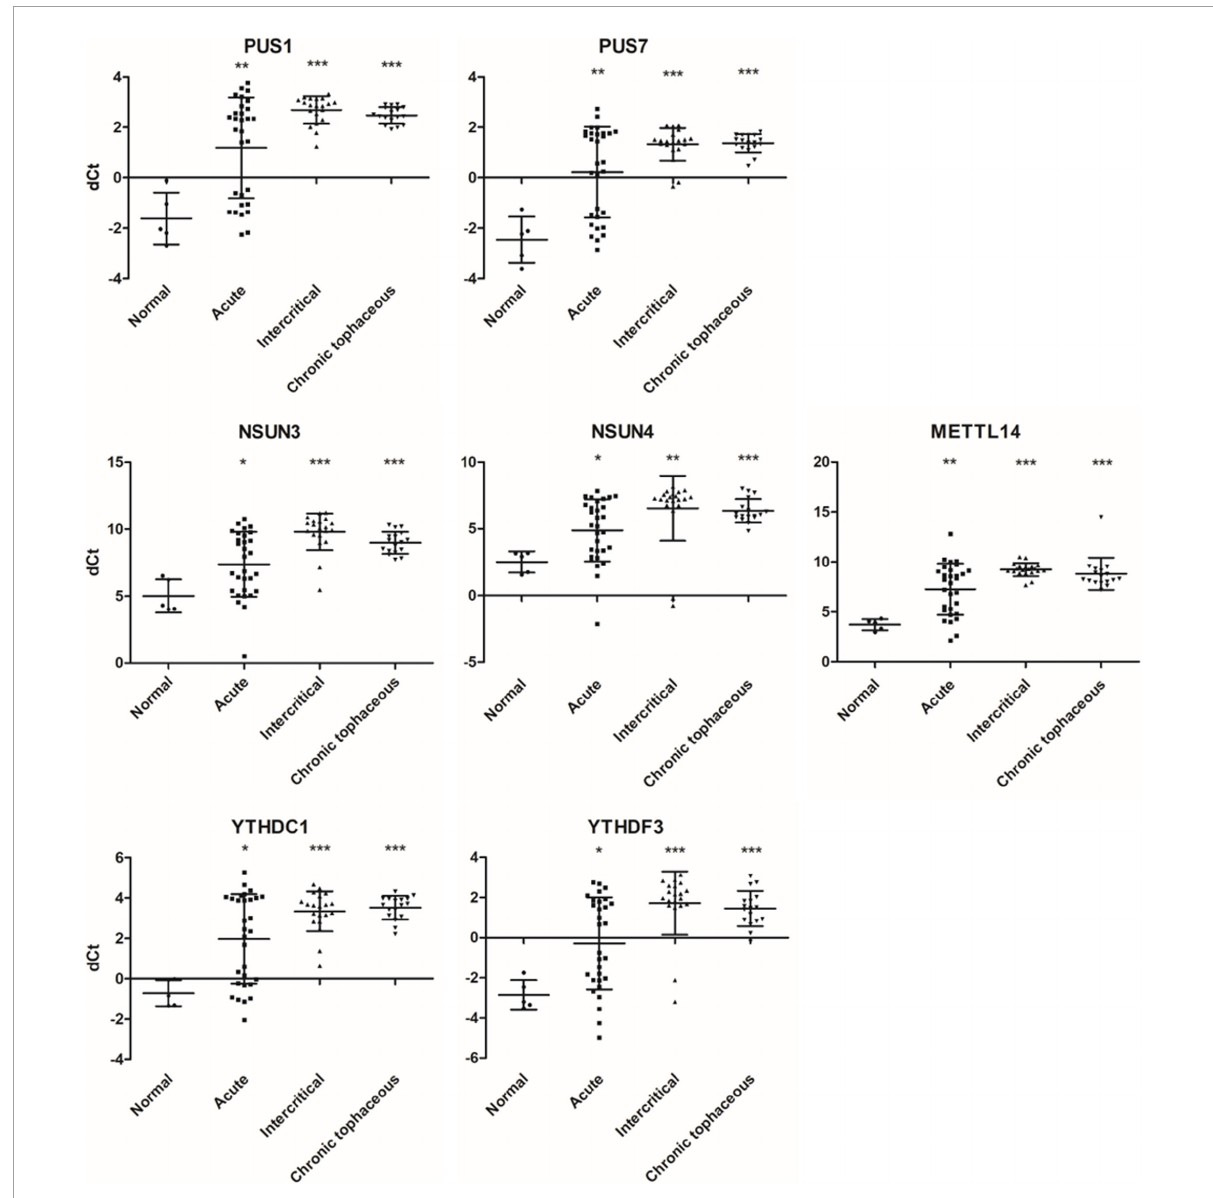
FIGURE9 RNA expressions of RNA modification enzymes were affected in patients with gout. The expressions of PUS1 , PUS7 , NSUN3 , NSUN4 , METTL14 , YTHDC1 , and YTHDF3 were detected through real-time PCR in 67 patients with gout, including 30 patients with acute gout, 20 with intercritical gout, and 17 with chronic tophaceous gout. Five normal samples were used as the control. Lines represent medians, and error bars represent standard deviation. * P < 0.05, ** P < 0.005, *** P < 0.0001 by Student’s t -test, compared with normal samples. RNA expression levels are shown as dCt ( ALAS1 as internal